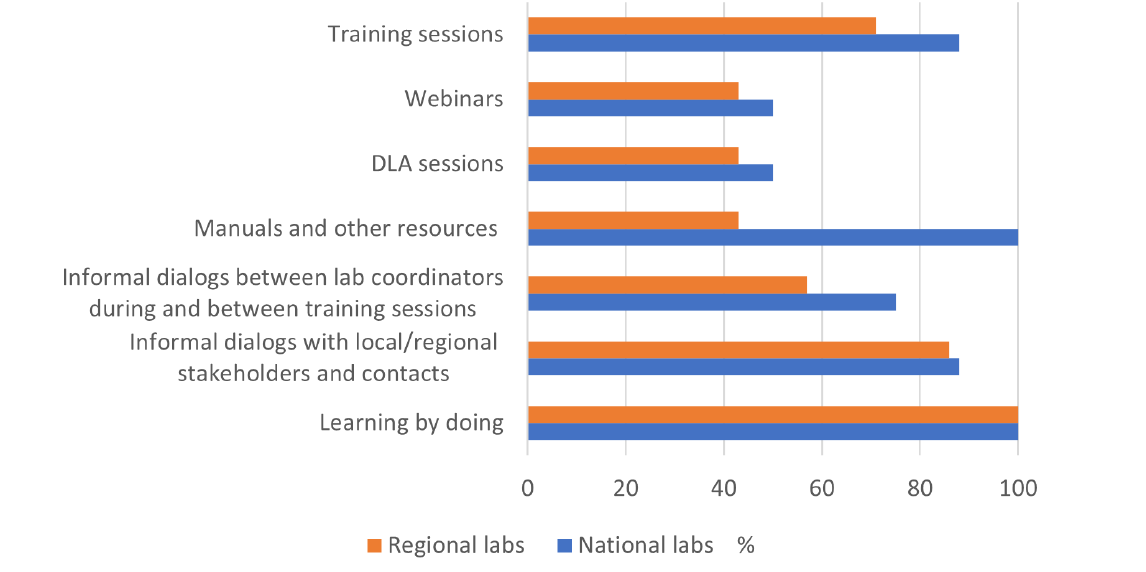
Fig. 1. Perceived usefulness of learning activities/resources (%). N = 7 regional labs, N = 8 national